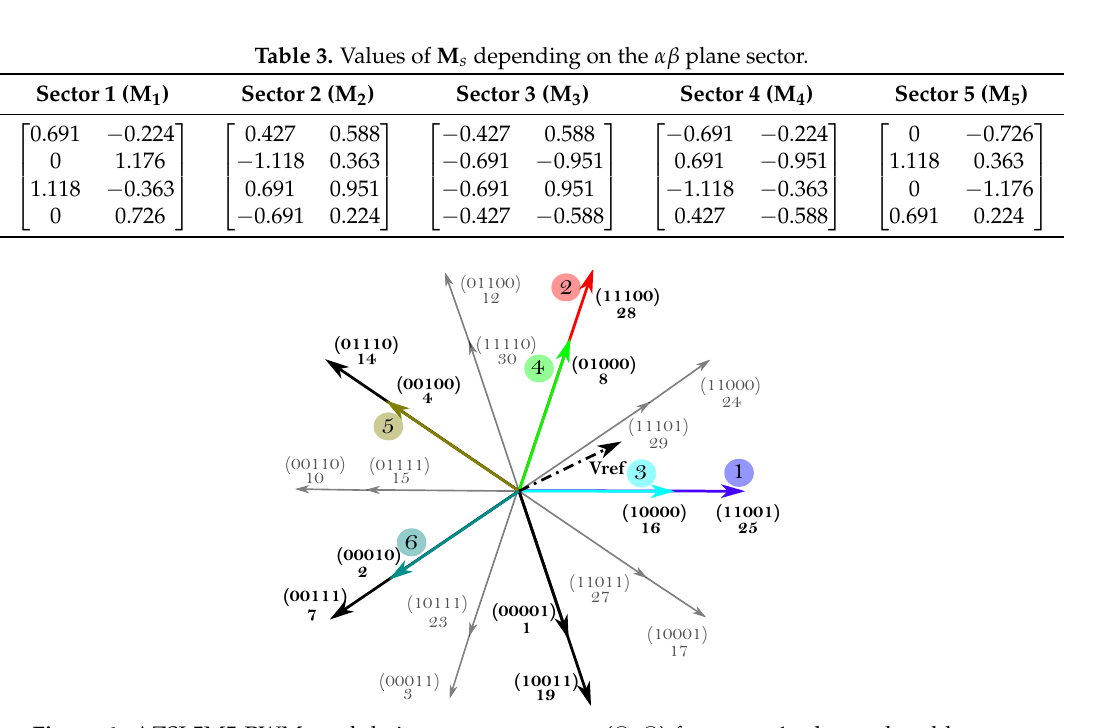
Figure 6. AZSL5M5-PWM modulation vector sequence ( (cid:192) – (cid:197) ) for sector 1 when only odd vectors are